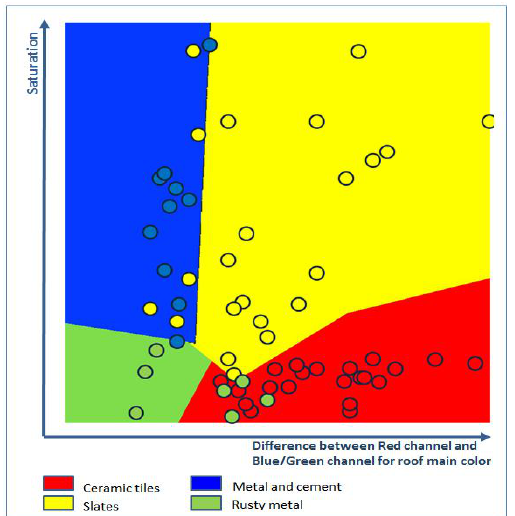
Figure 2. Example of SVM roof classification with